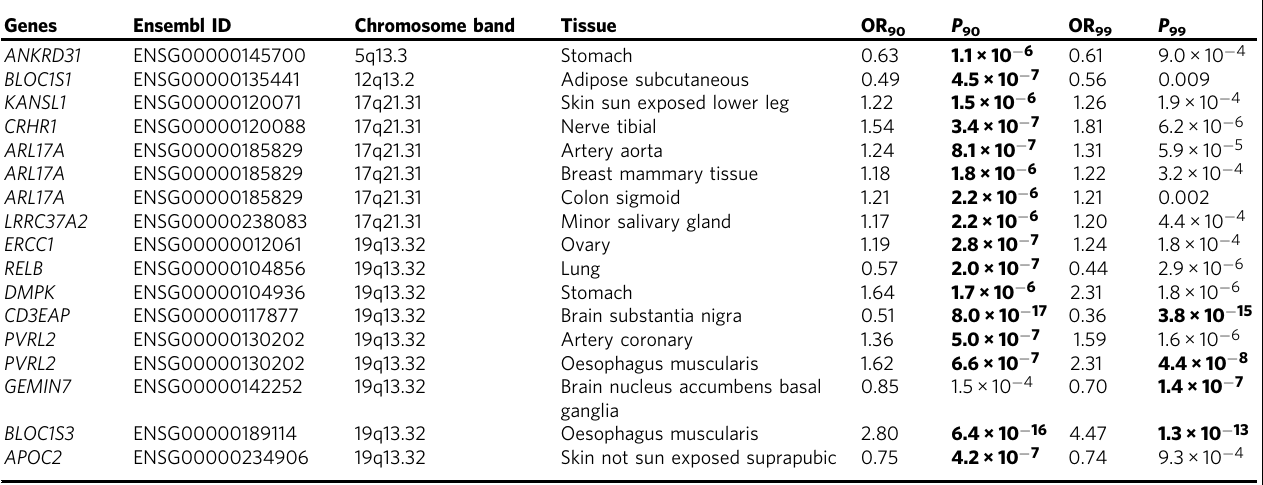
Table 5 Results of the gene-level association analyses Genes